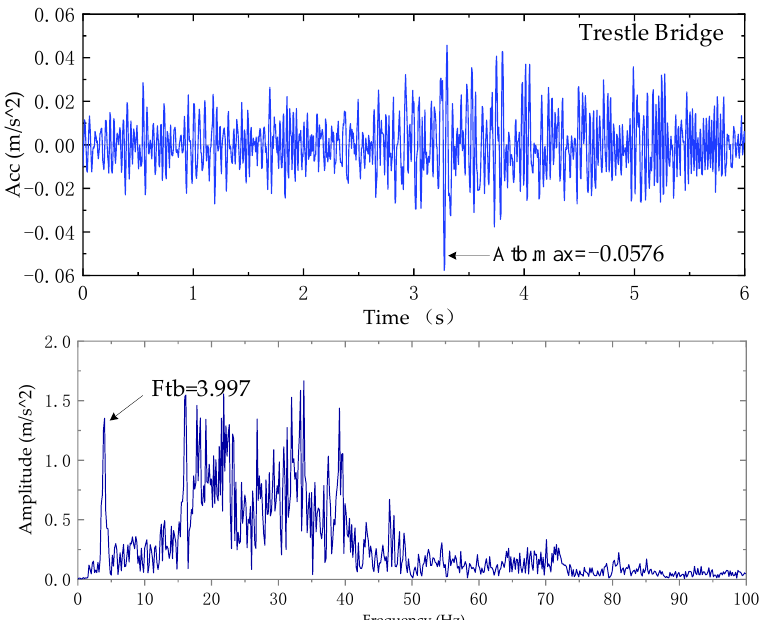
Figure 12. Vibration response of concrete trestle bridge.